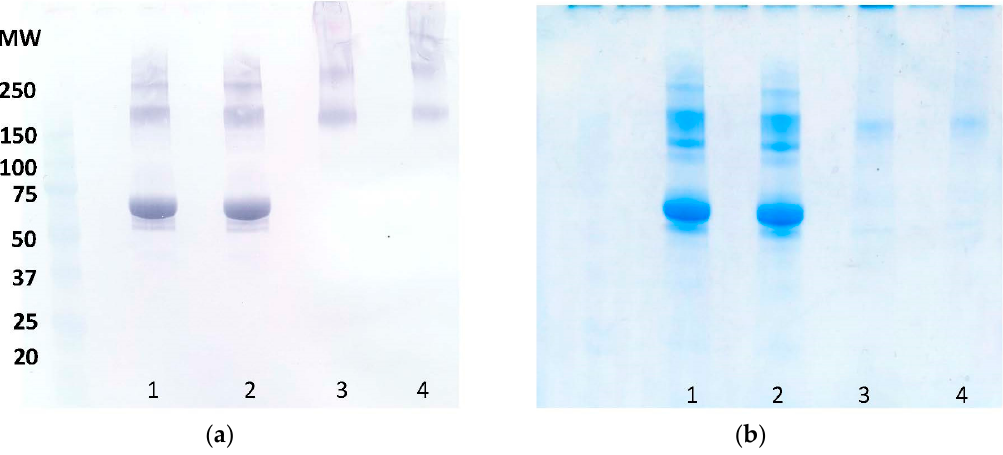
Figure 6. Immunostaining of SSI-HYB 387-01 reactivity. ( a ) Western blotting of SSI-HYB 387-01 reactivity to full-length glutamic acid decarboxylase (GAD)67 protein. ( b ) Coomassie Brilliant Blue staining of recombinant GAD67. Lane 1 + 2: reduced recombinant GAD67, lane 3 + 4: non-reduced recombinant GAD67.